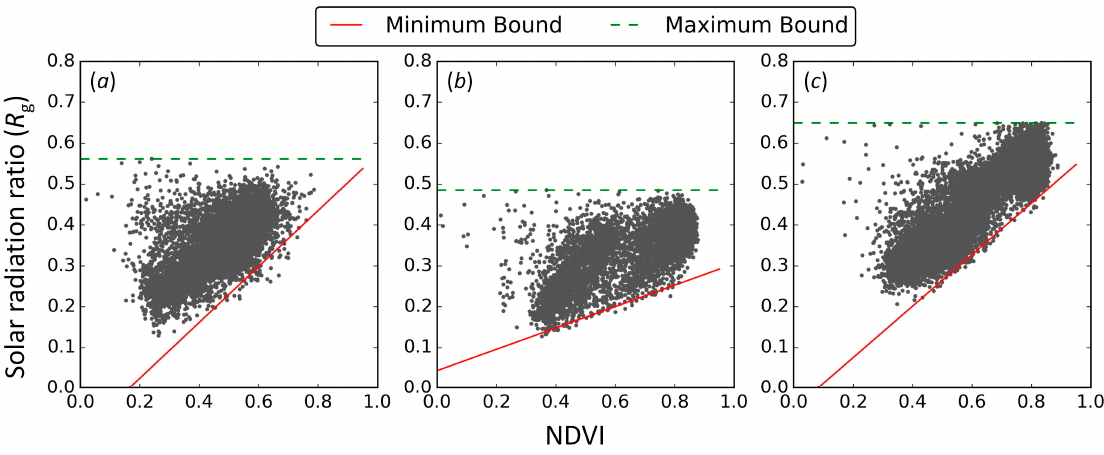
Figure 4. R g -NDVI scatter observed on selected days over ( a ) Site 3, ( b ) Site 4, and ( c ) Site 5.